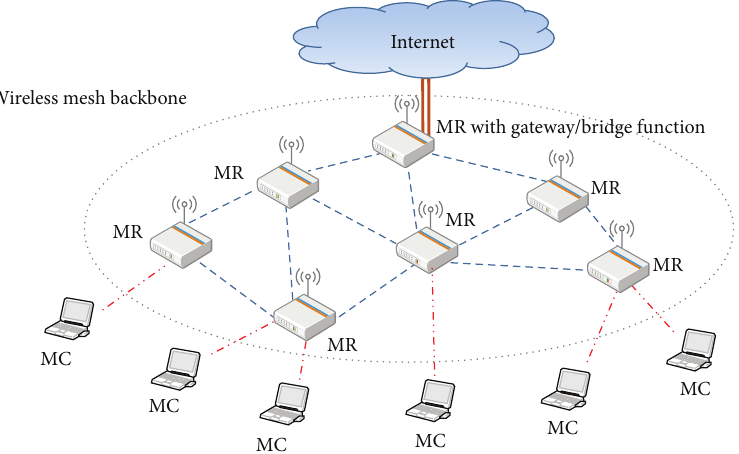
Figure 1: Illustration of a wireless mesh